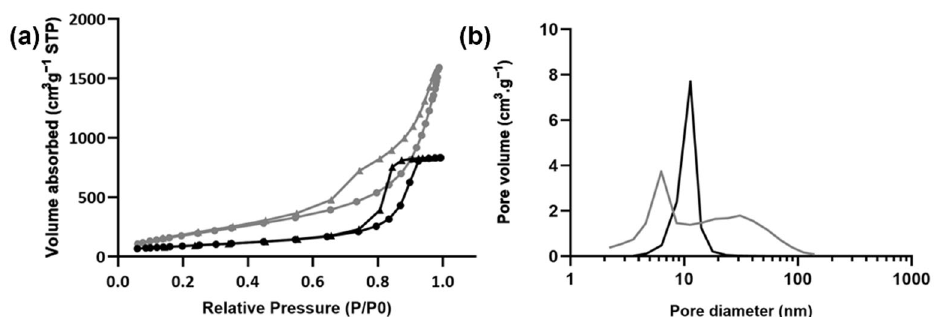
Figure 2. BJH analysis of pectin ‐ based (black) and silica ‐ based (grey) aerogels. ( a ) Adsorption (circles)/desorption (triangles) isotherms and ( b ) specific pore volume distribution.